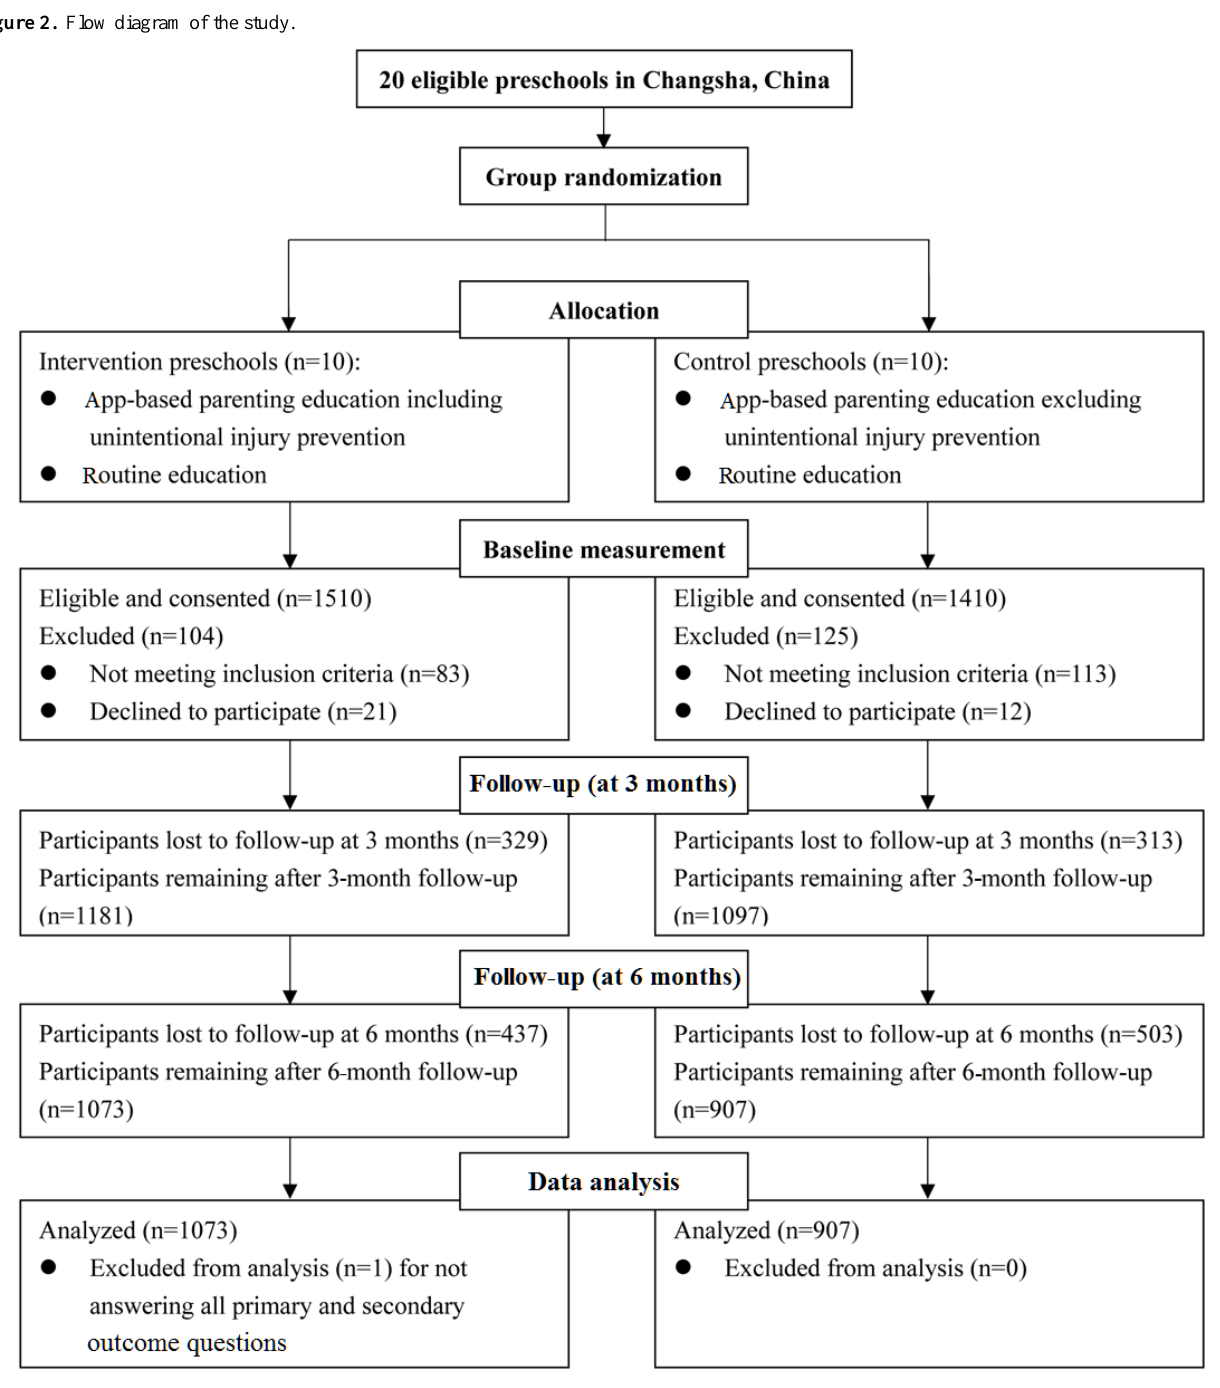
Figure 2. Flow diagram of the